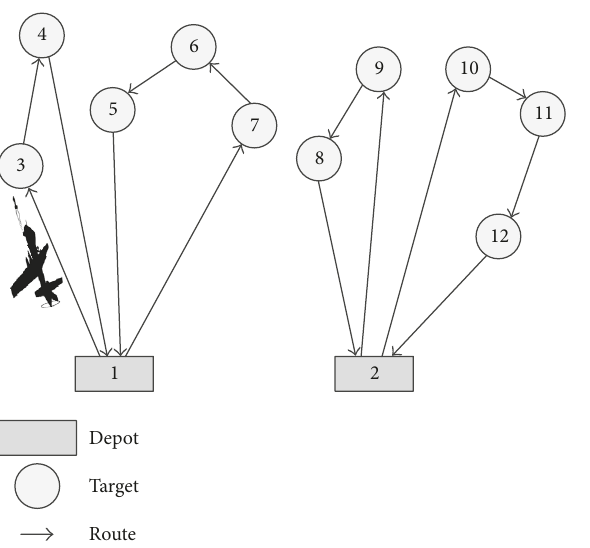
Figure 1: An illustration of the